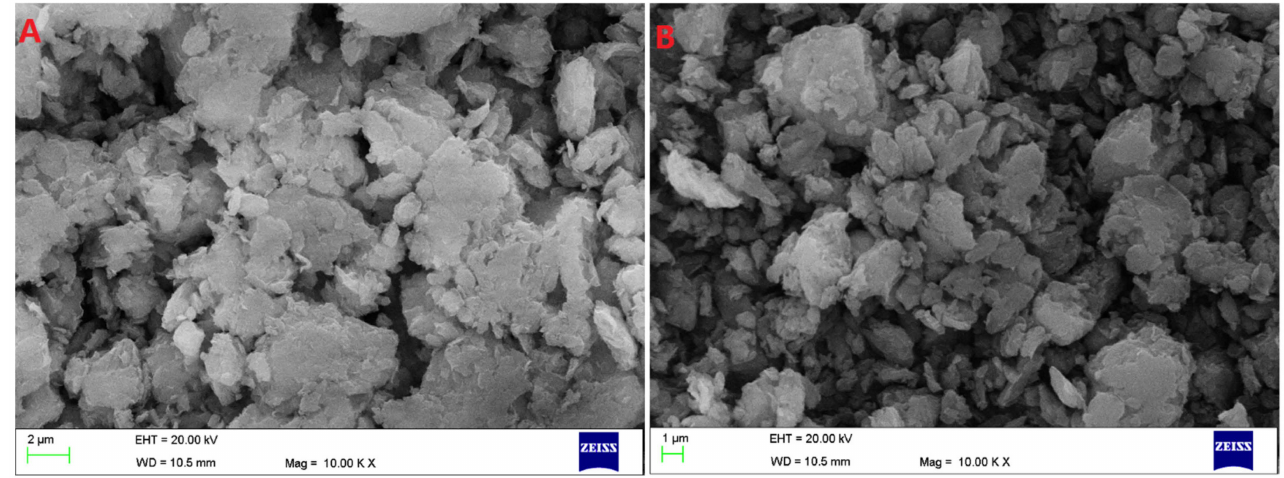
Figure 2. The morphology of MMt ( A ) and Al 13 -O-MMt ( B ) characterized by